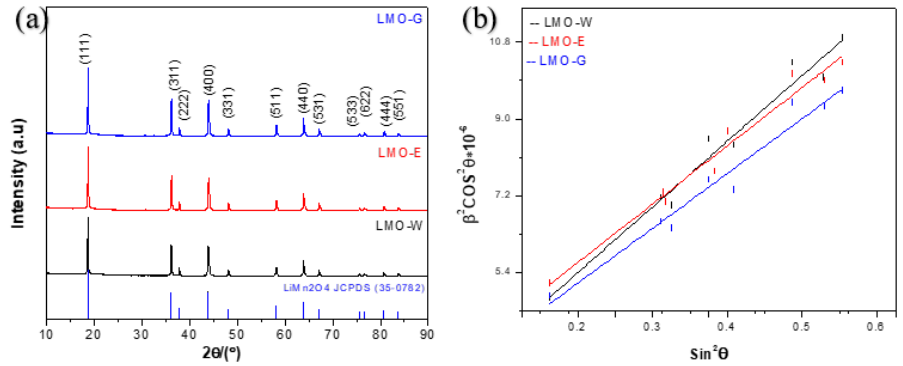
Figure 3. XRD patterns of ( a ) LMO samples. ( b ) Analysis of the full width at half maximum β of the Bragg peaks.